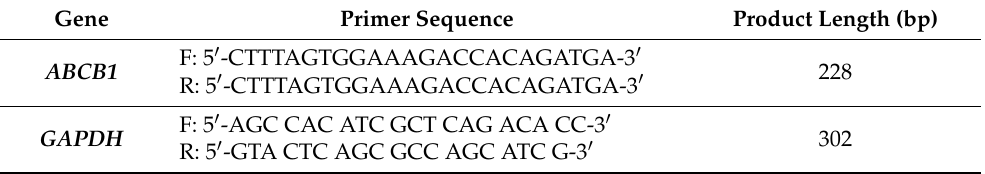
Table 4. Sequences of the primers used for